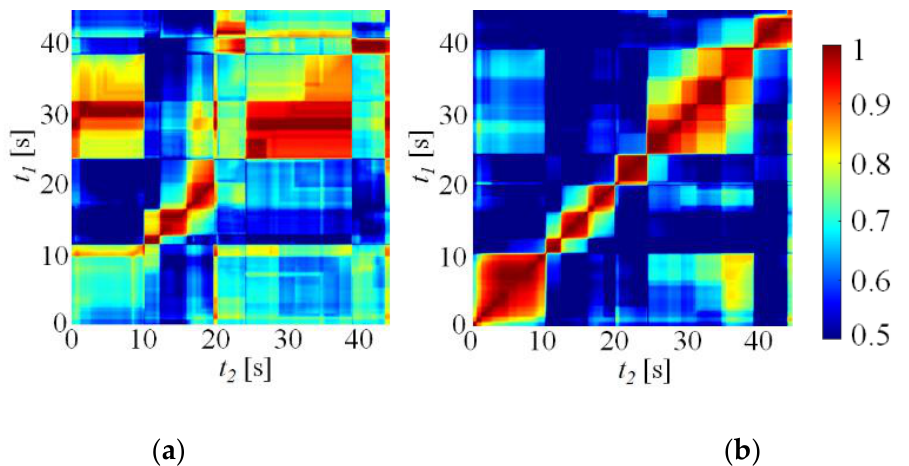
Figure 5. Cross-correlations of heat fluxes at two positions of Ch7 at Q ele = 0.5 W, ( a ) 7a and 7d, ( b ) 7c and 7d.